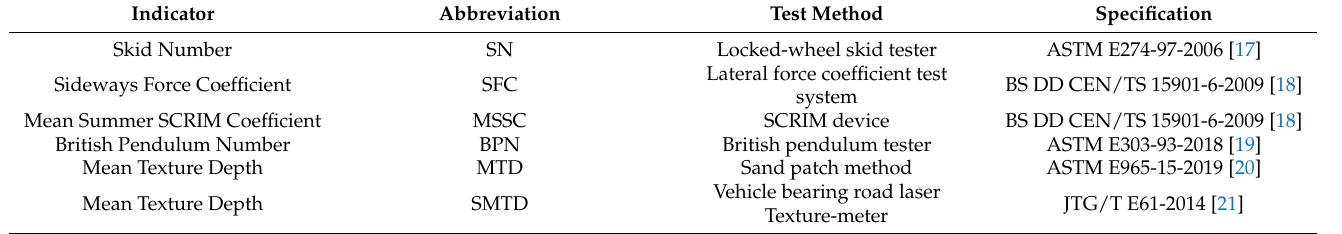
Table 2. Test methods for the characterization of skid resistance.